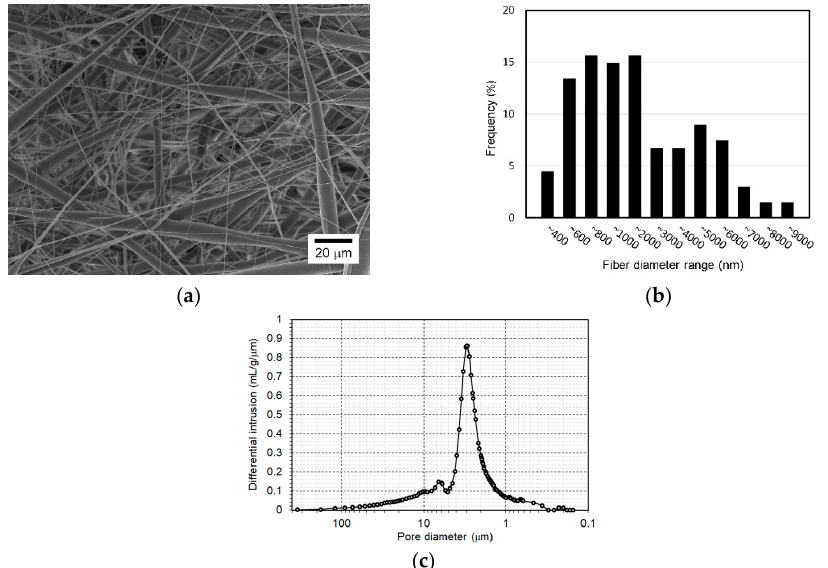
Figure 3. Electrospun nanofiber scaffold: ( a ) SEM images; ( b ) diameter distribution of the electrospun fibers; ( c ) porosity analysis